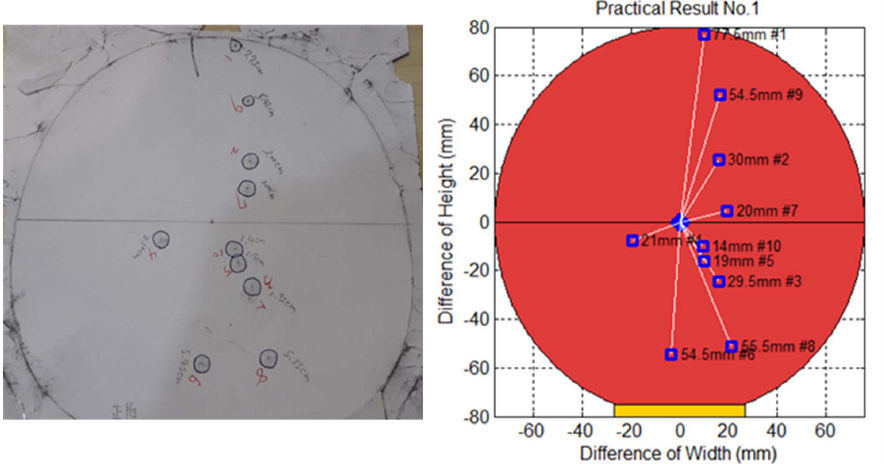
Figure 21. Striking points on carbon paper.